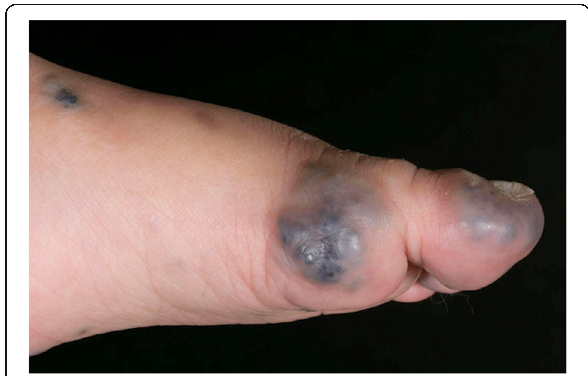
Fig. 7 Multiple cutaneous lesions with the classic features of blue rubber bleb naevi in a 2 year old